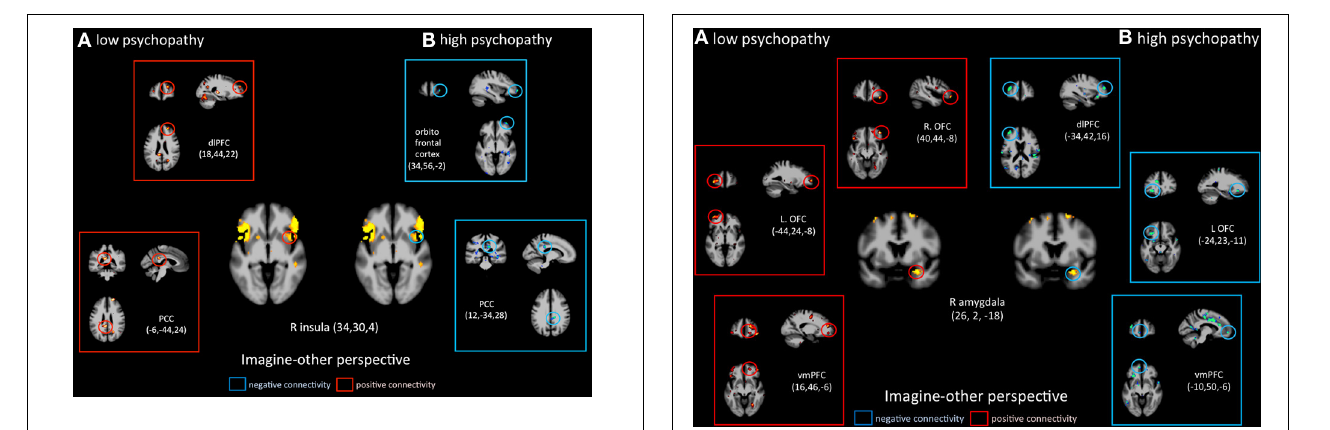
FIGURE 5 | Functional connectivity analyses, seeded in the anterior insula in participants with the lowest scores on the PCL-R and participants with the highest scores on the PCL-R ( > 30) during imagine-other perspective.